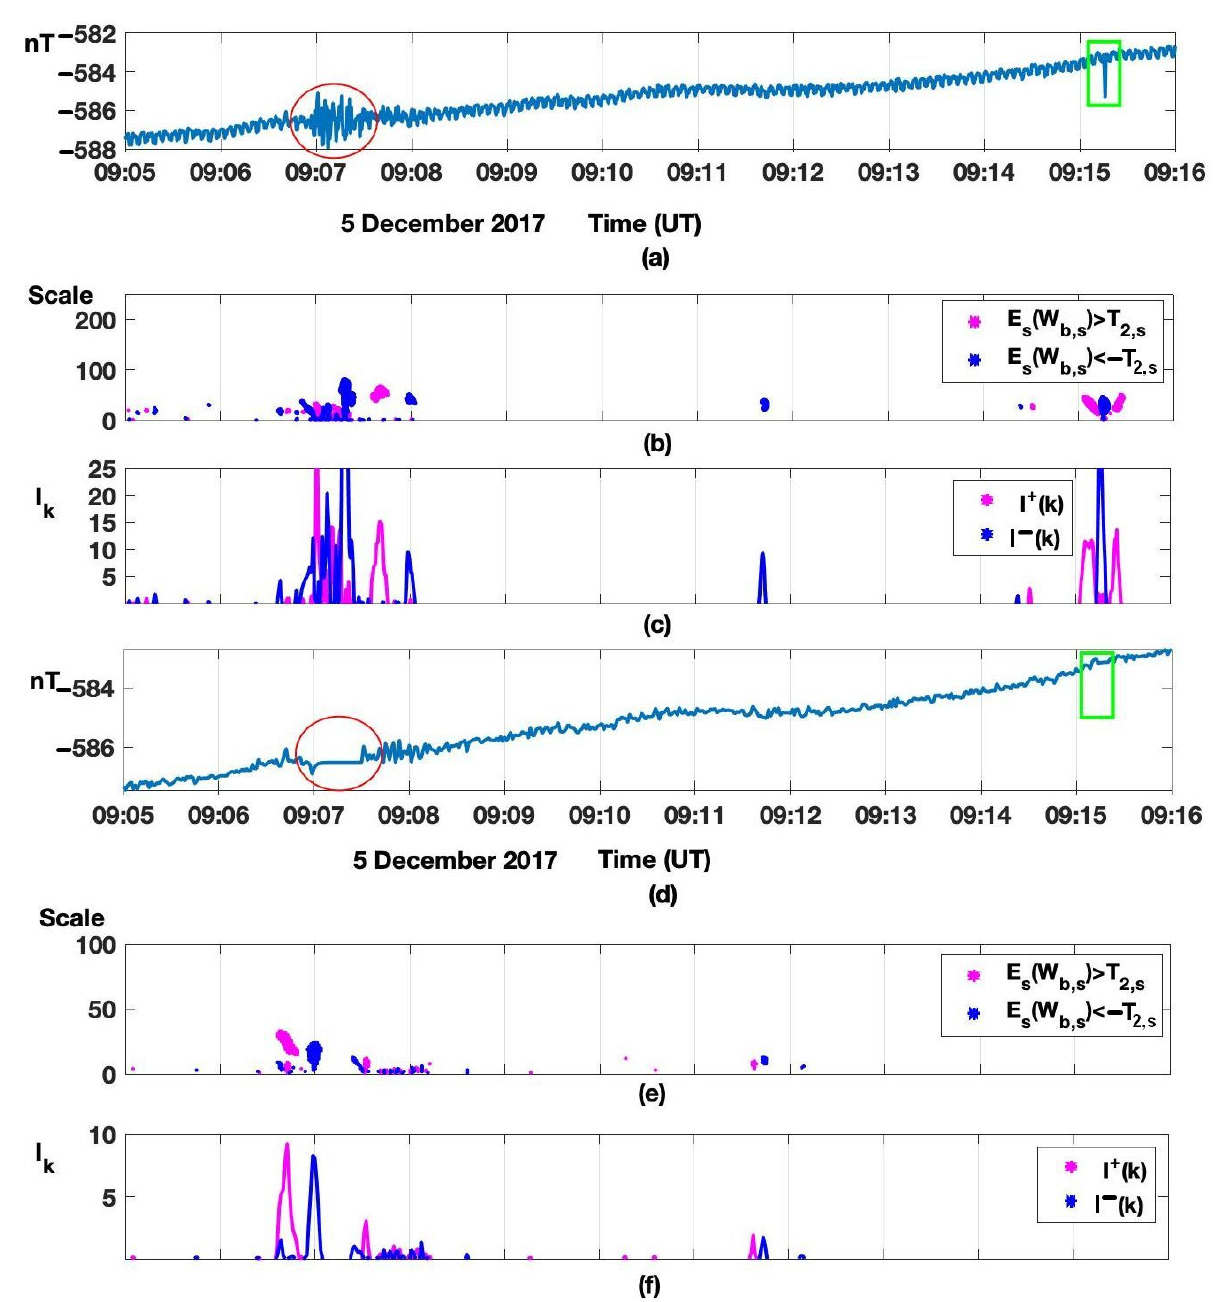
Figure 6. Processing results for Z-component variations on 5 December 2017. ( a ) Z-component, noisy; ( d ) Z-component, cleared; ( b , c , e , f ) results of method